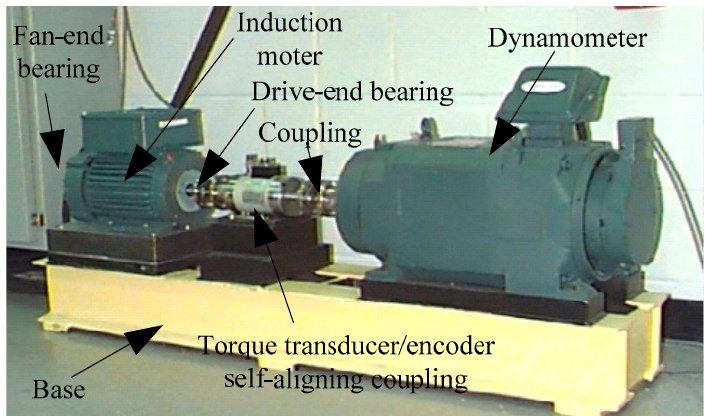
Figure 5. The experimental platform of rolling bearing from Bearing Data Center of Case Western Reserve University. Table 1. Experimental sample description of the rolling bearing.